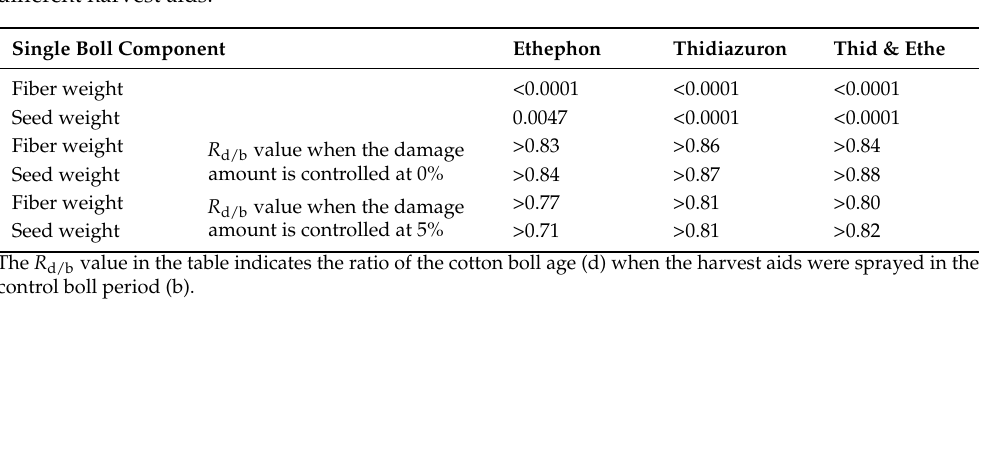
Table 4. Correlation analysis and appropriate R d/b value of a single boll component damage under different harvest